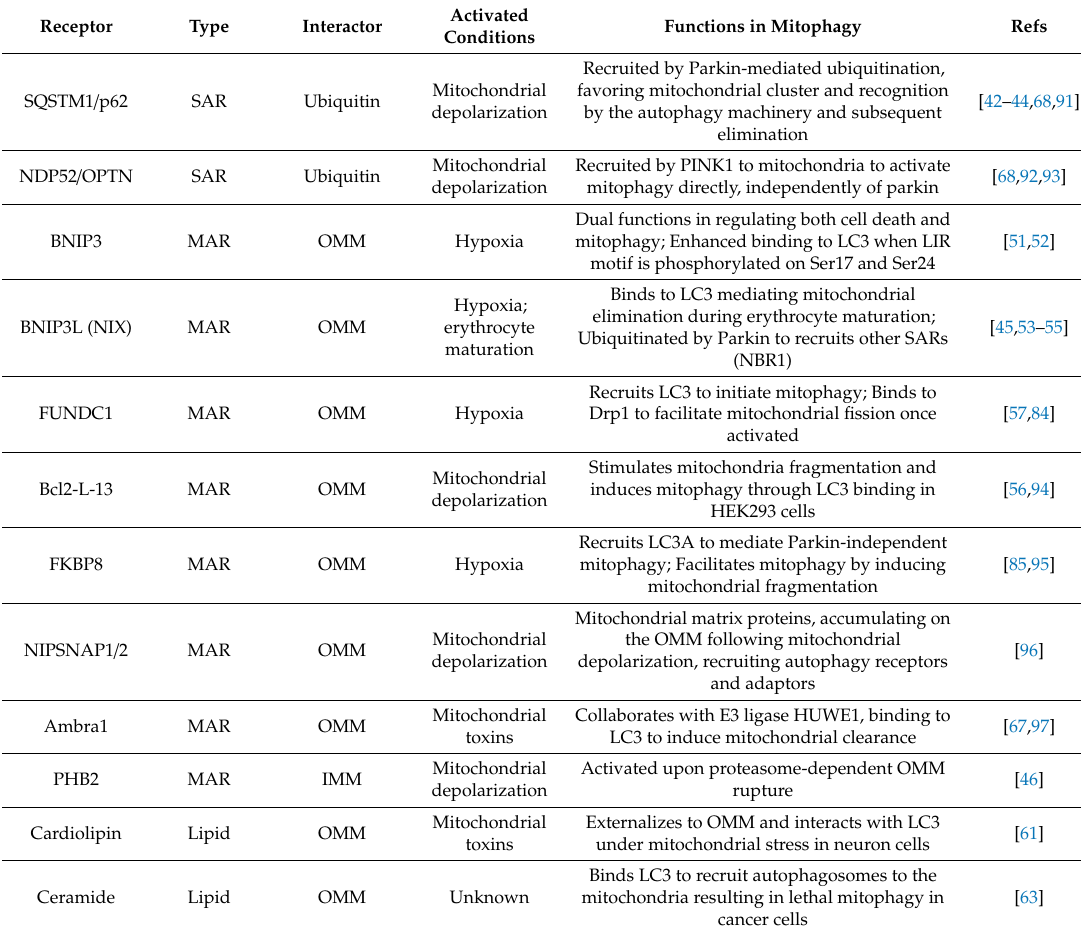
Table 1. Identified mitophagy receptors in mammalian